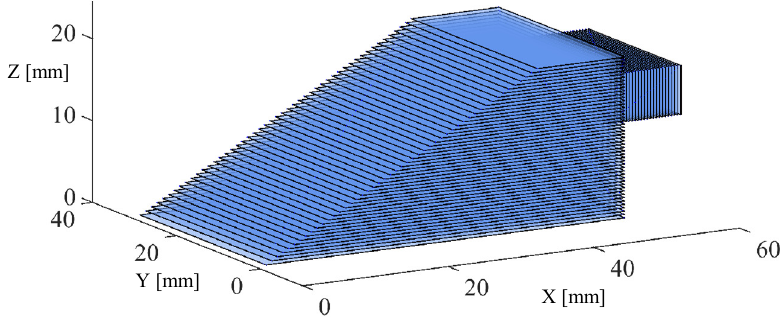
Figure 8. The result of the multidirectional slicing